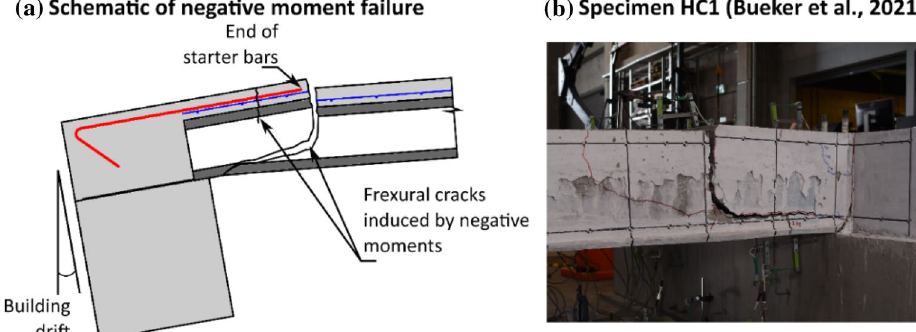
Fig. 3 Negative and positive flexural failure in a hollow-core floor system [adapted from Fenwick et al.